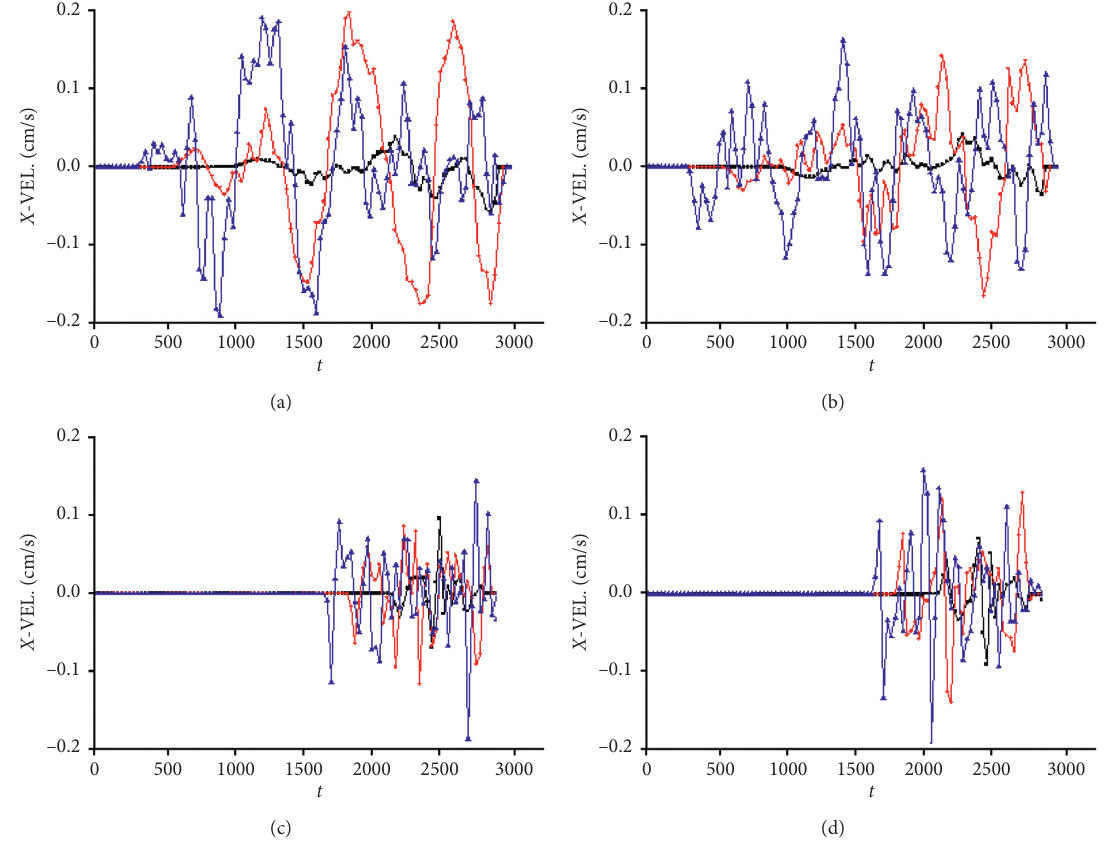
Figure 11: Velocity–time history curves of different monitoring points. (a) Model 1, x -direction. (b) Model 1, y -direction. (c) Model 2, x -direction. (d) Model 2, y -direction.